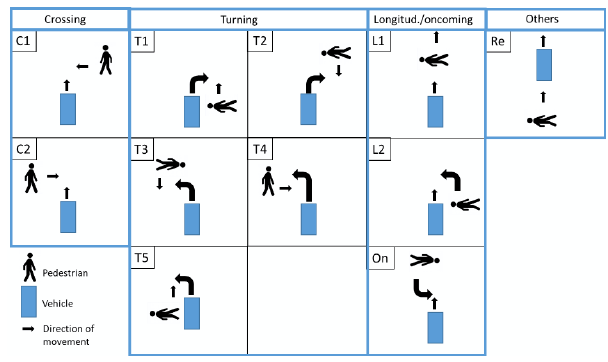
Figure 1 Classification of fatal pedestrian accident scenarios